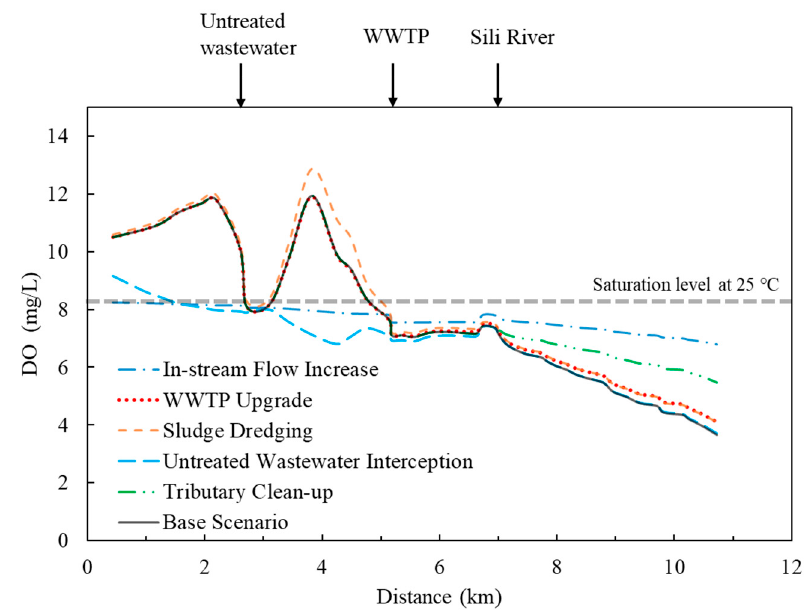
Figure 8. Scenario analysis of engineering controls for DO level improvement in the Nanfei River. Grey dash line represents DO saturation level at 25 °C.